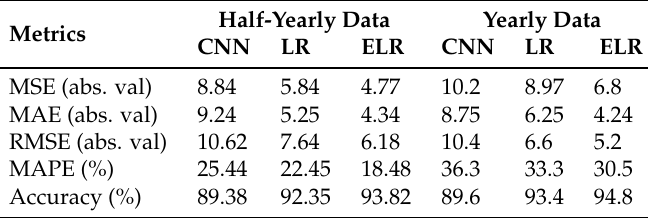
Table 13. Load performance metrics comparison for one day using the UMass Electric Dataset.